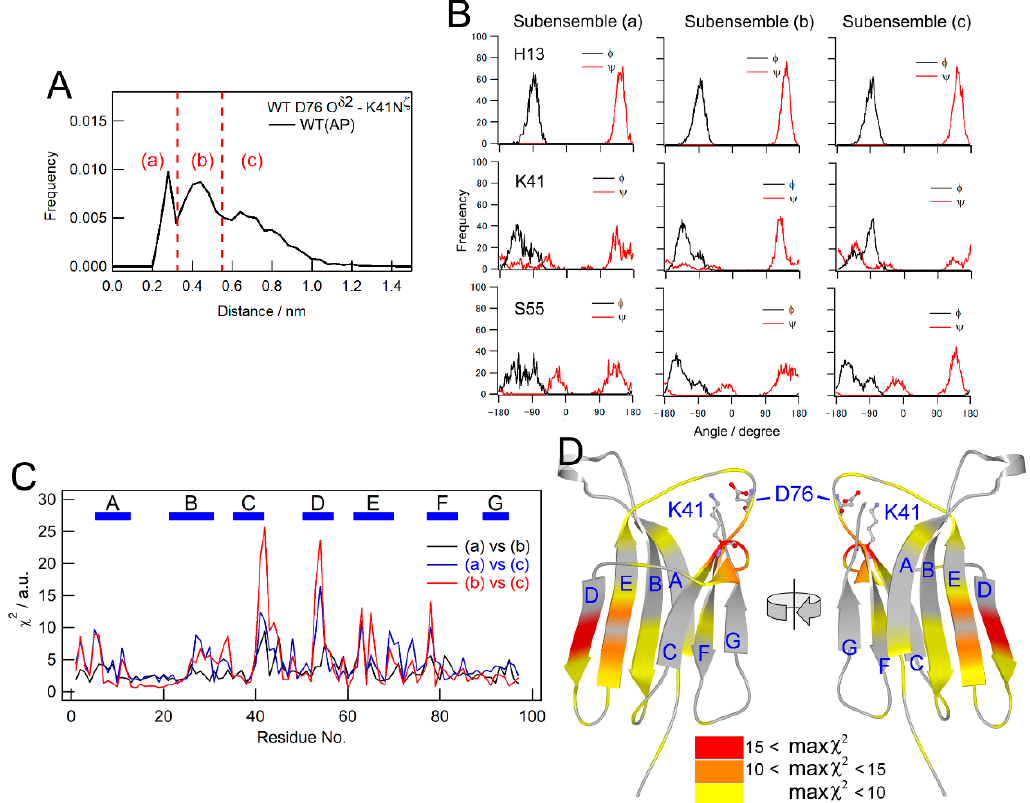
Figure 6. Correlation of dynamics between main chain conformations for all residues and the mutation site. ( A ) The distribution of distance between D76 and K41 side chains for WT at ambient pressure. The dotted lines are the borders separating the three subensembles, named (a), (b), and (c), of the conformation with di ff erent side chain distances. ( B ) The dependence of the dihedral angles of the representative residues (H13, K41, and S55) on the distance between the D76 and K41 side chains. ( C ) χ 2 values as an indicator of the degree of the dependence of the dihedral angle distribution on the D76-K41 side chain distance. ( D ) The mapping of max χ 2 values among those obtained for the three combinations ((a) vs. (b), (a) vs. (c), and (b) vs. (c)) on the crystal structure. Colors indicate χ 2 values, as shown by the color gauge below.